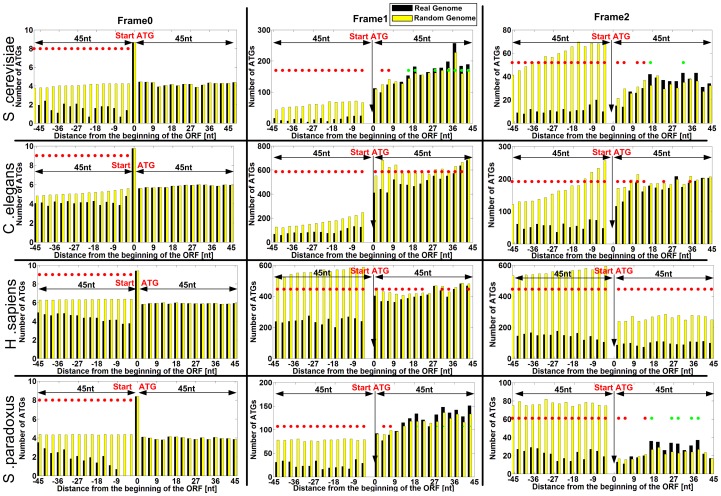
Comparison of the genomic profiles of number of ATGs in the three frames (in black), to the one obtained for randomized genomes (in yellow) with the same proteins, GC content, and codon bias, for four model organisms (S.
cerevisiae, C. elegans, H. sapiens , S. paradoxus).A red/green dot corresponds to a position where the number of alternative ATG codons is significantly lower/higher than expected in the randomized genome model (details in the Methods section). The figure demonstrates that there is selection for less ATGs (red dots) in the 5′UTR and also at the beginning of the ORF. The positions with more ATGs than expected (green dots) after the beginning of the ORF may be related to yet unknown codon bias signals in that region. See supplementary Figures S1, S2, S3, S4, S5, S6, S7, S8, S9, S10, S11, S12, S13, S14, S15, S16, S17, S18, S19, S20, S21, S22, S23, S24, S25, S26, S27, S28, S29, S30, S31, S32, S33 for detailed figures of all 33 analyzed organisms, for two types of genome randomizations (Methods).